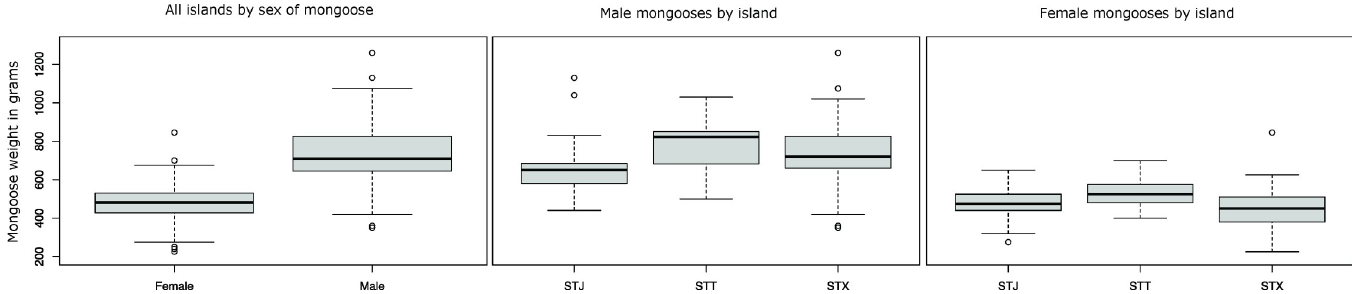
Fig 4. Mongoose (n = 312) weight (grams) comparisons by sex and island � —United States Virgin Islands, 2019–2020, including St. Croix (STX), St. John (STJ), and St. Thomas (STT).